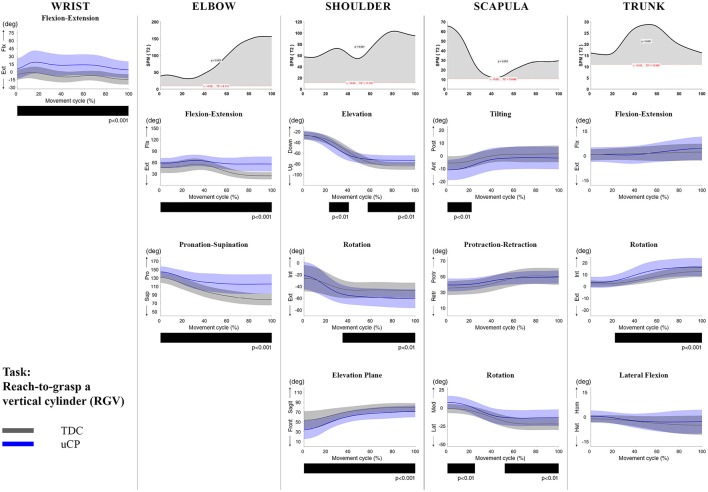
Comparison between children with uCP and TDC during the RGV task for all joint angles. Each column corresponds to a joint (from left to right: wrist, elbow, shoulder, scapula, and trunk). The top image of each column is the SPM output of the vector field analysis (Hoteling's test, except for the wrist, where a t-test was computed). Below, mean (bold line) and standard deviation (translucent area) of the TDC (gray) and uCP (blue) of each vector component, and the respective post-hoc SPM{t} output. The black bar under each kinematic profile indicates clusters of significant difference between groups.